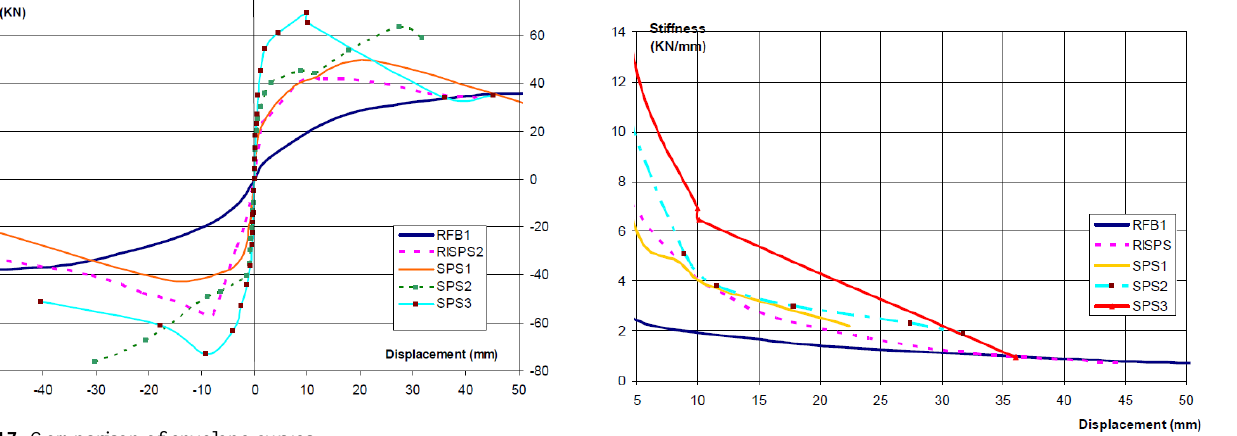
Fig. 18. Ratio of specimen ultimate load to the reference empty specimen’s ultimate load.